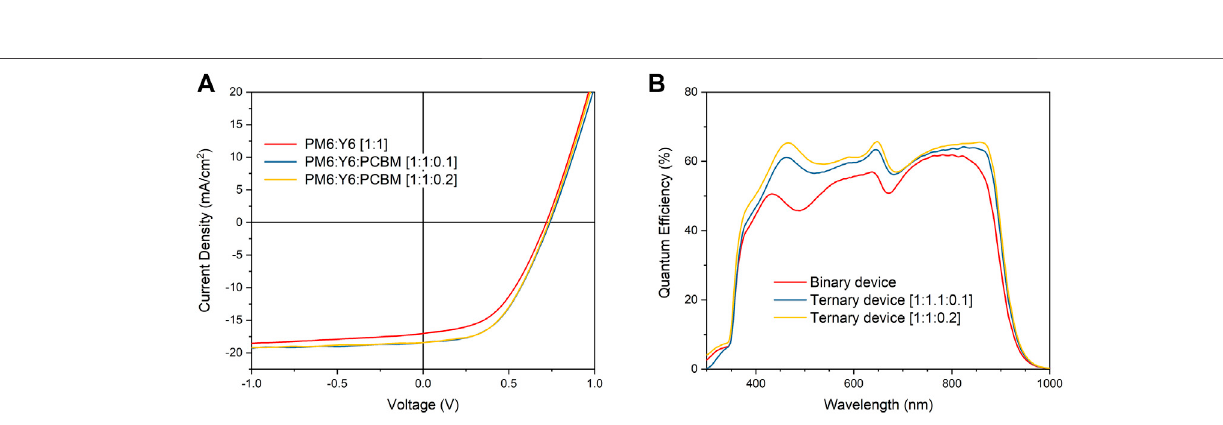
Frontiers in Nanotechnology |